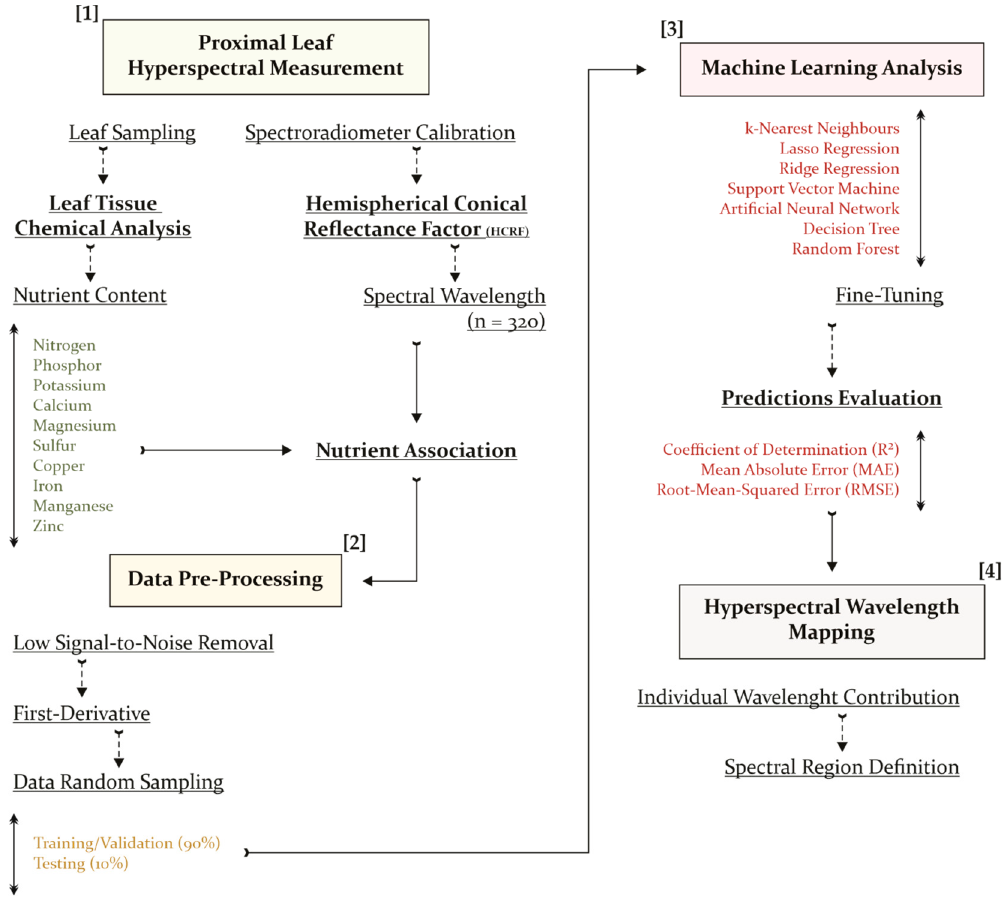
Figure 1. The workflow of the four main processes adopted for the proposed approach.